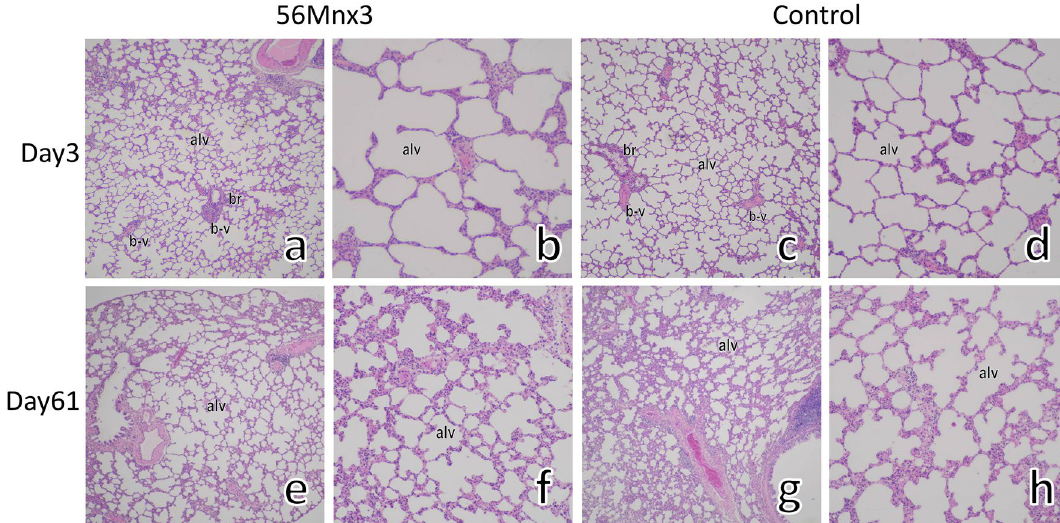
Figure 1. The rats’ lungs on days 3 ( a – d ) and 61 ( e – h ) after 56 MnO 2 exposure and the control (HE staining). There were no significant histological alternations in the lungs among Mn56x3 ( a , b , e , f ) and the control ( c , d , g , h ) groups. The structure of alveoli (alv) was normal with bronchiole (br) and blood vessels (b-v) in the Mn56x3 group. There were no signs of thickening of the alveolus wall even on day 61 postexposure ( f ) compared to the control ( h ). Original magnification × 40 ( a , c , e , g ), or × 100 ( b , d , f , h ).